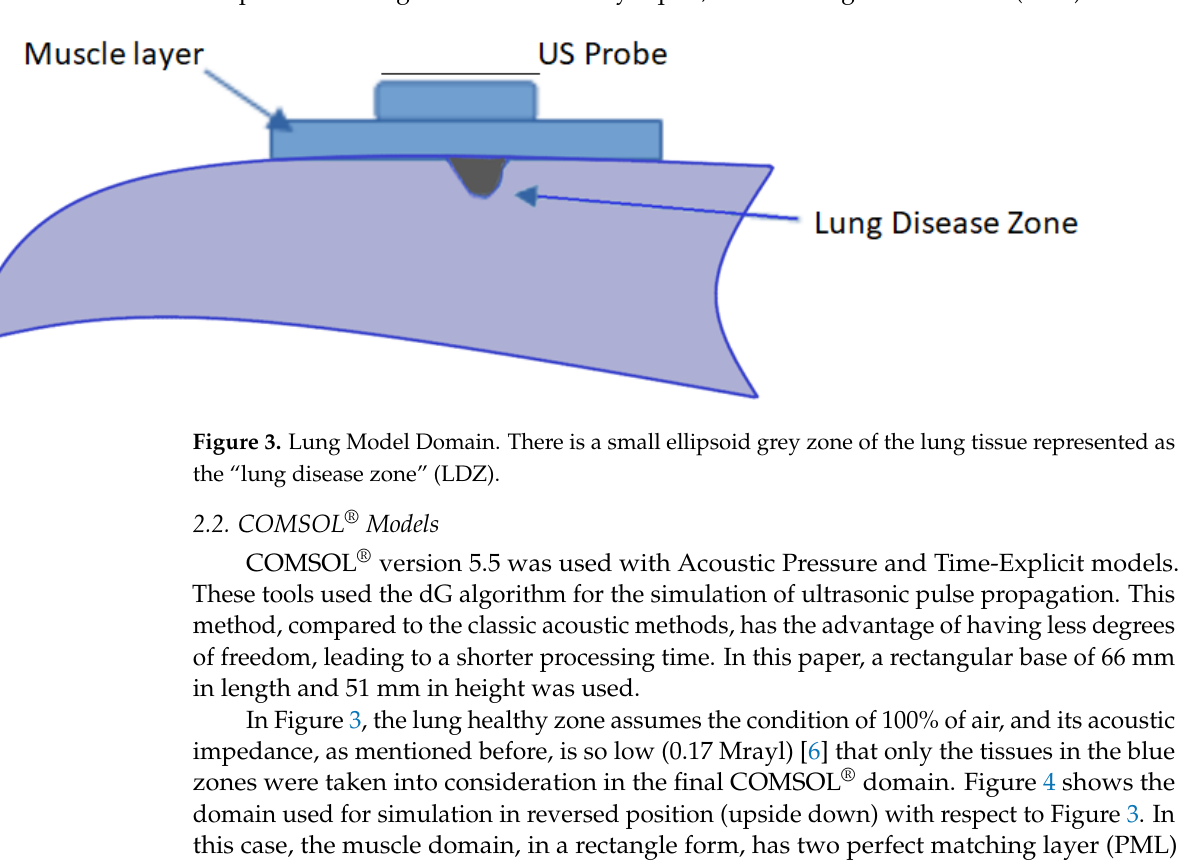
3 of 12 Figure 2. Three examples of B-lines. B-lines are vertical hyperechoic, well-defined and laser beam-like lines that emerge at the pleural level, erasing the A-lines, and move in synchrony with the respiratory cycle. Reprinted/adapted with permission from [10]. 2022, Acoustical Society of America. Understanding physical phenomena using mathematical models is a commonly